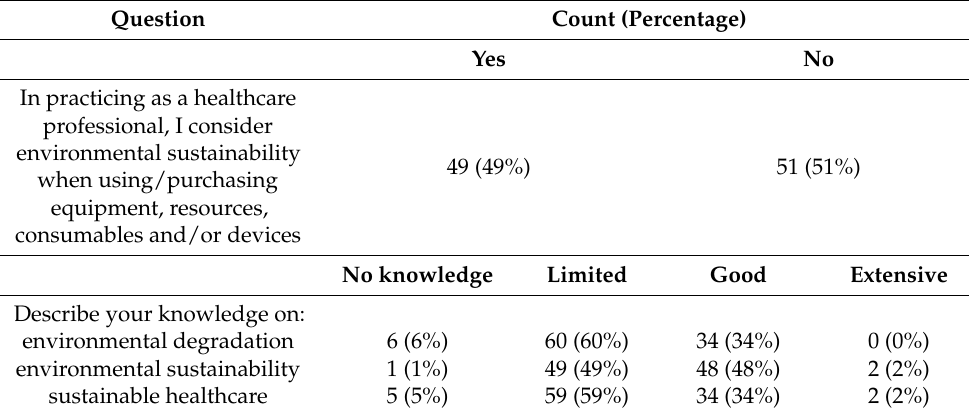
Table 3. Knowledge ( n =